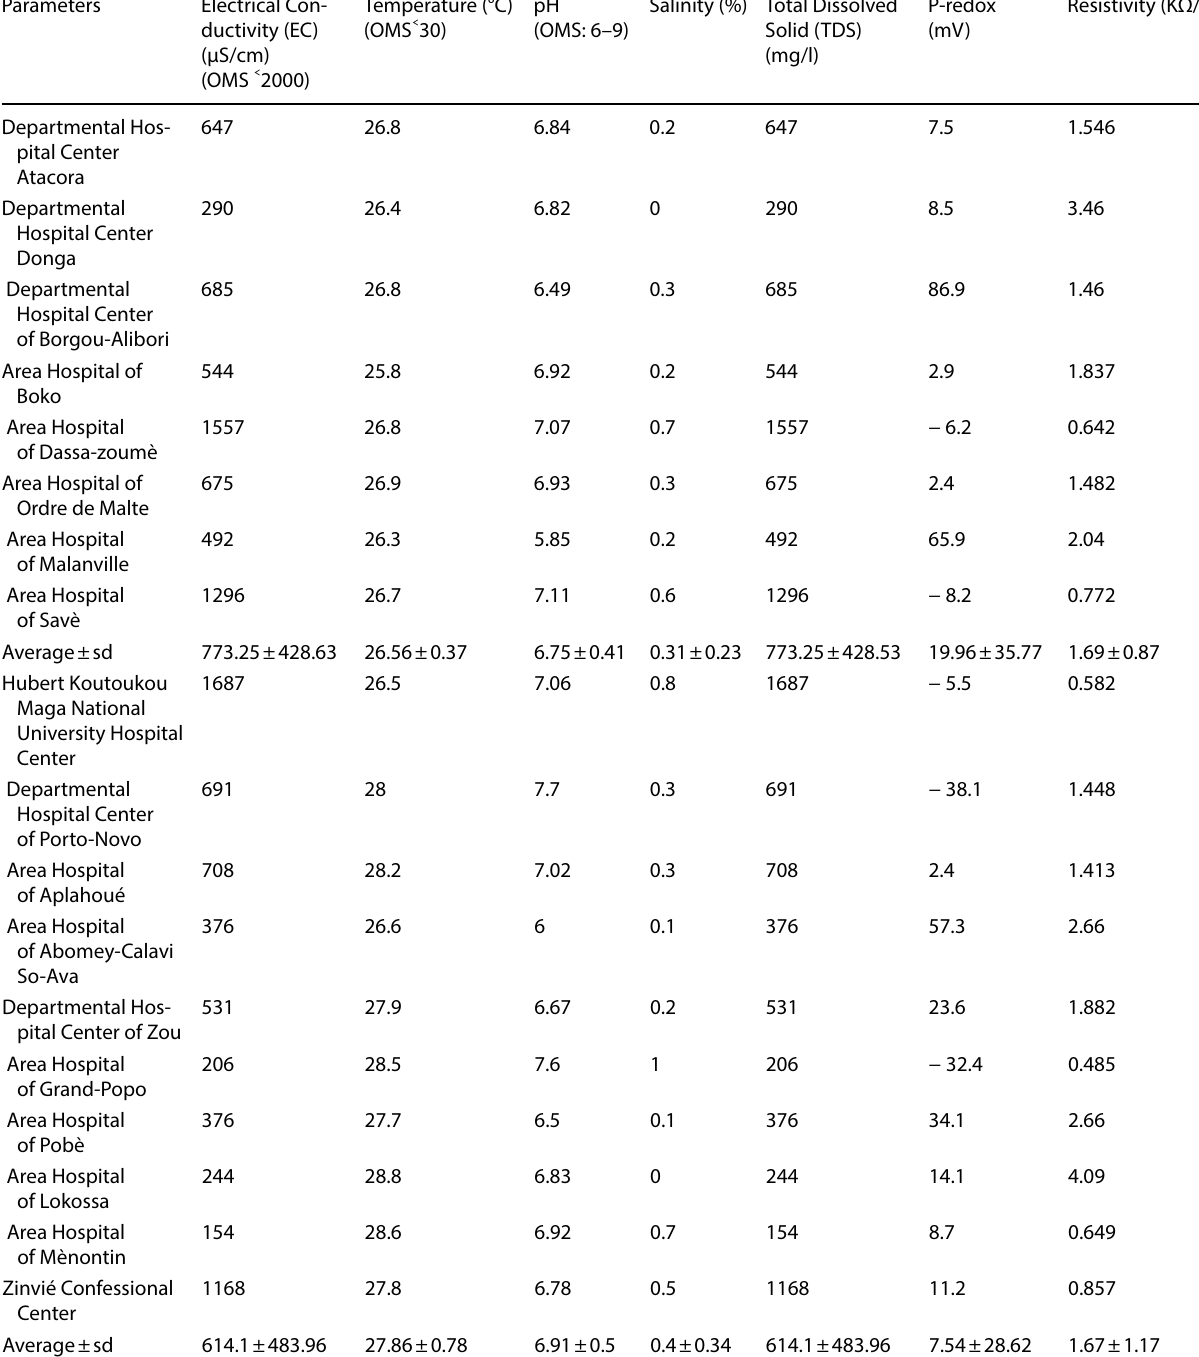
Table 2 Physico-chemicals analysis characterization